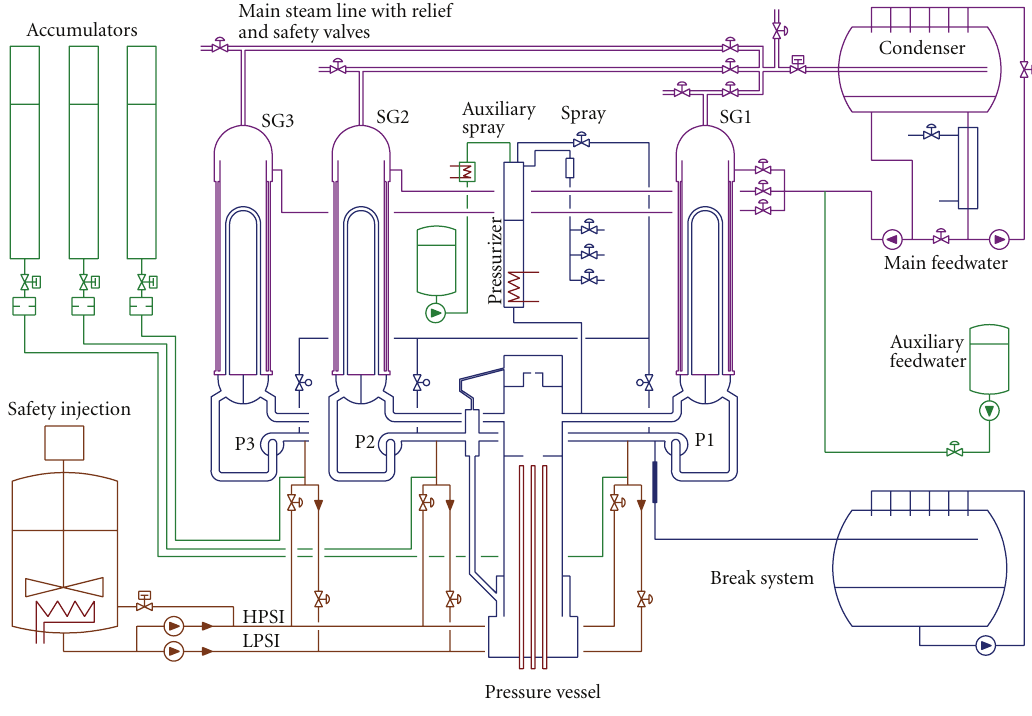
Figure 1: BETHSY schematic